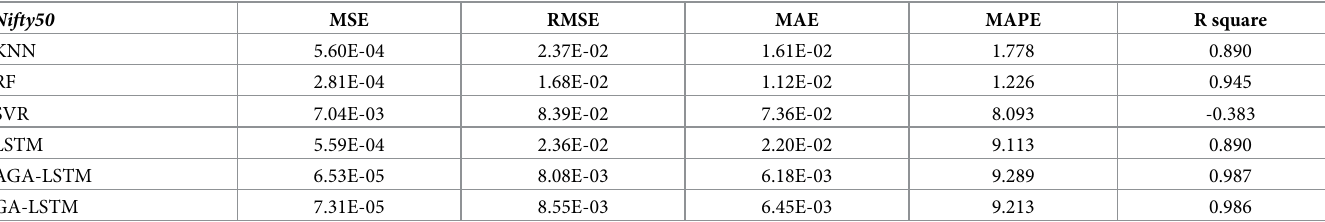
Table 12. The evaluation indexes of AGA-LSTM model and other DL models in Nifty50 date